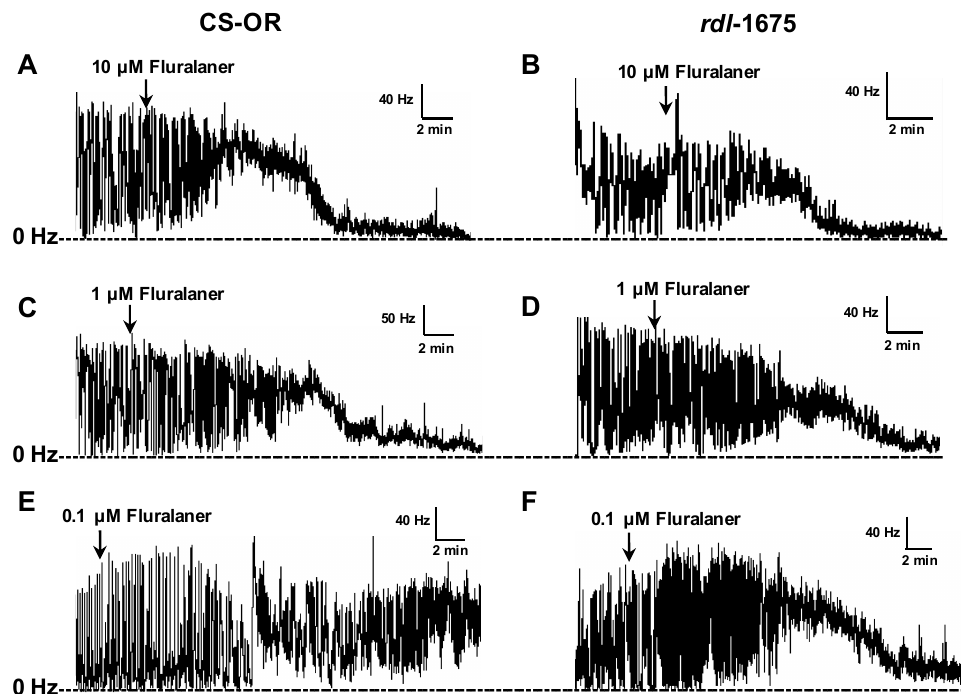
Figure 6. Electrophysiological recordings on CS-OR or rdl -1675 D. melanogaster intact larval CNS. ( A ) CS-OR CNS treated with 10 µM fluralaner; ( B ) rdl -1675 CNS treated with 10 µM fluralaner; ( C ) CS-OR CNS treated with 1 µM fluralaner; ( D ) rdl -1675 CNS treated with 1 µM fluralaner; ( E ) CS-OR